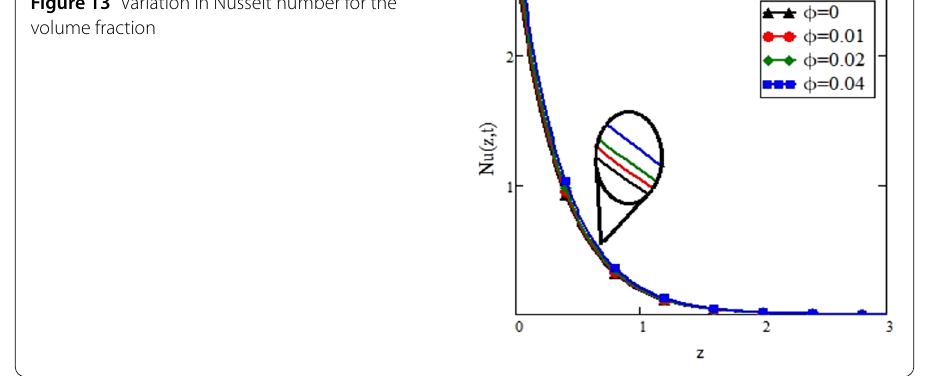
Figure 14 Influence of Sc on the concentration